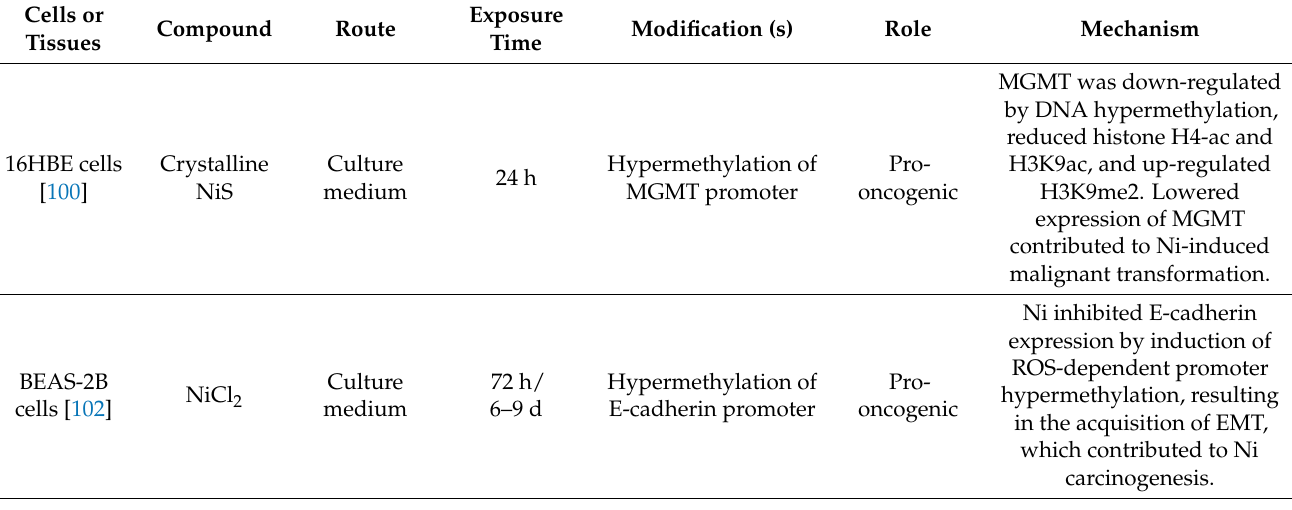
Table 4. Roles of altered DNA methylation in Ni-induced